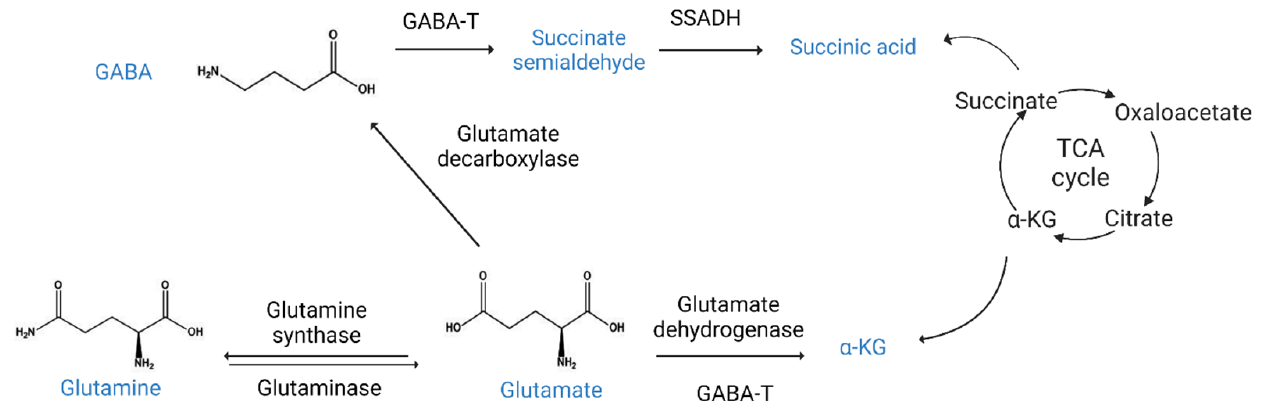
Figure 4. GABA biosynthesis and catabolism. The major biosynthesis pathway of gamma- aminobutyric acid (GABA) from glutamine and alpha-ketoglutarate (a-KG). Glutaminase catalyzes the reaction of transforming glutamine to glutamate. The reverse reaction is controlled by glutamine synthase. Glutamate dehydrogenase (GDH) transforms glutamate to a-KG. Glutamate decarboxylase (GAD) catalyzes the reaction of transforming glutamate to GABA. GABA transaminase converts GABA to succinate semialdehyde. Succinic semialdehyde dehydrogenase (SSADH) catalyzes the reaction of transforming succinate semialdehyde (SSA) to succinic acid.